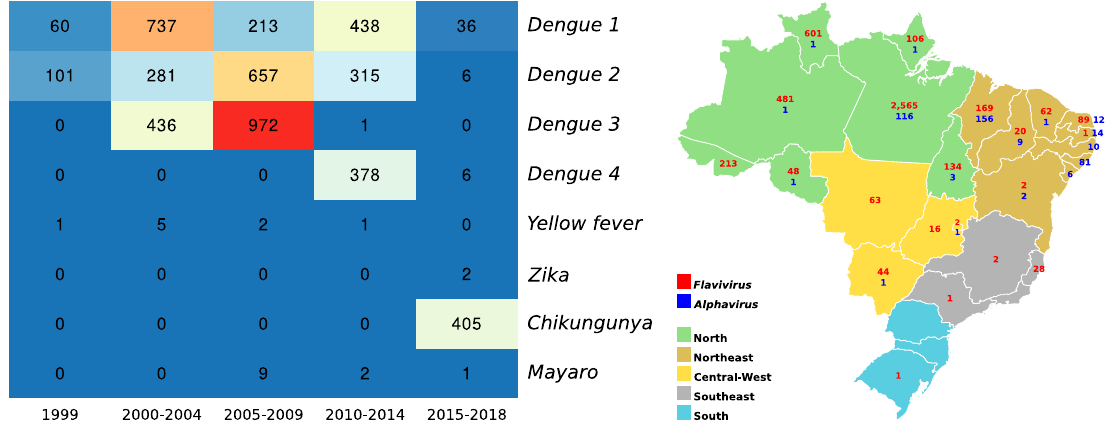
Figure 7. Distribution of alphavirus isolates in mice according to the animal model of origin. The larger heatmap is associated with isolates in the state of Pará. The smaller heatmap is associated with isolates from other Brazilian states.